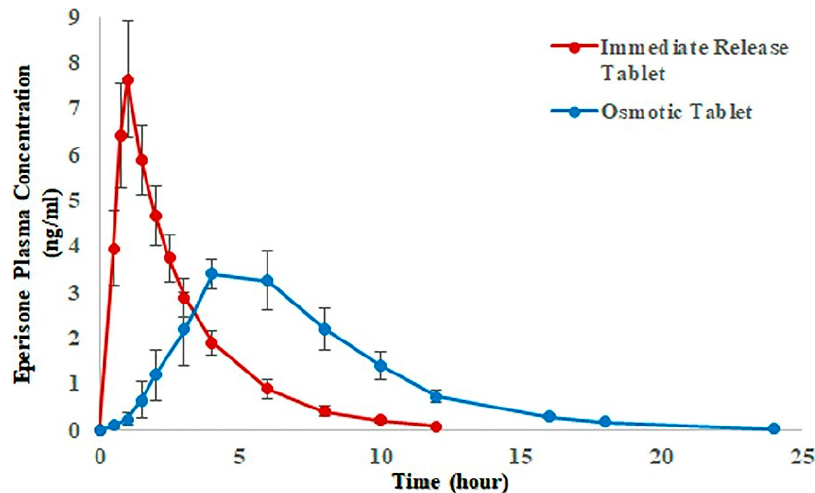
Figure 4. Mean plasma concentration versus time profiles obtained after administration of Eperisone 150 mg CR (controlled release) osmotic and immediate release tablets in 12 healthy subjects (Adapted from [77], Nature Research, 2020).